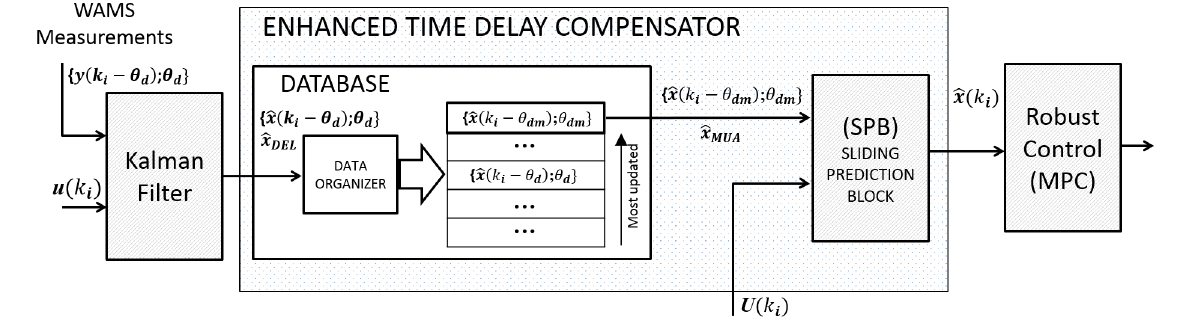
Figure 3. The Enhanced Time-Delay Compensator scheme.